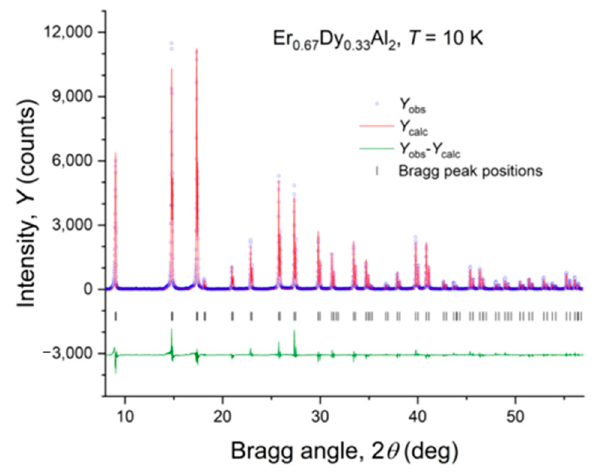
Figure 6. The Rietveld refinement of the X ‐ ray powder diffraction pattern of the Er 0.67 Dy 0.33 Al 2 measured at 10 K using the cubic model (R p = 11.3%, R B = 5.1%).